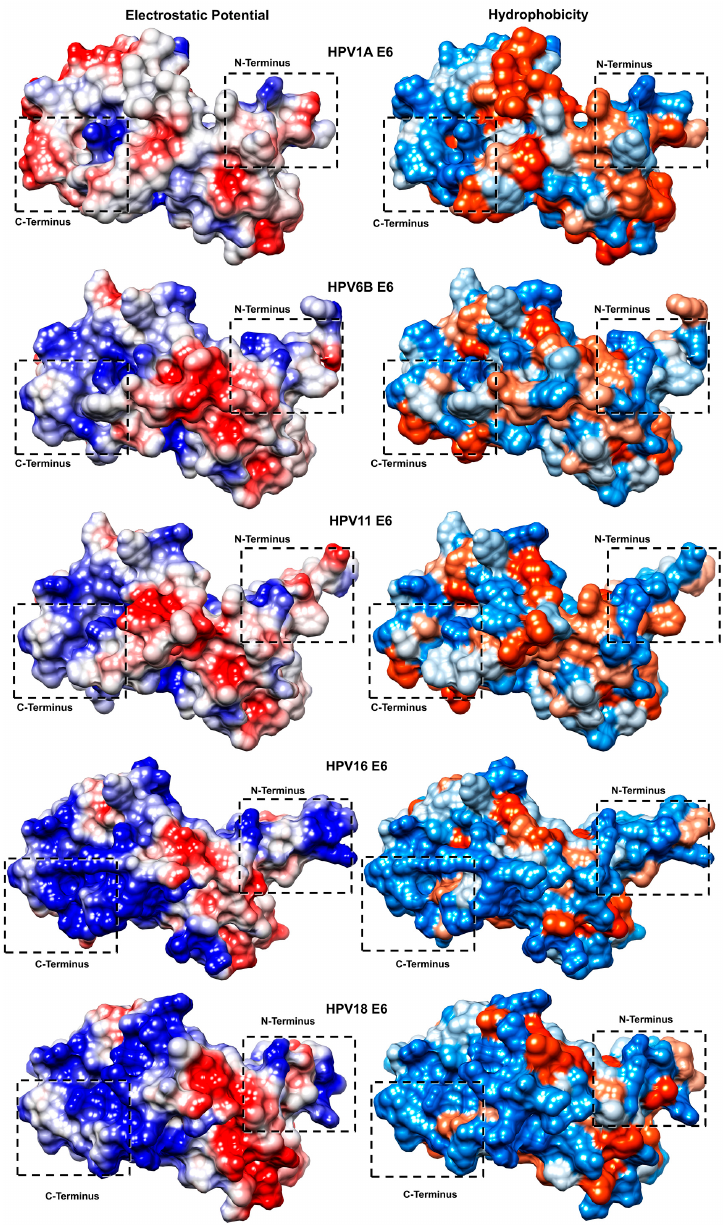
3 Figure 6. Distribution of electrostatic potential and surface hydrophobicity. The electrostatic potential distribution is shown in blue in the positively charged regions, red in the negatively charged regions, and white in the neutral regions. The hydrophobicity distribution on the protein surfaces is shown in blue for hydrophilic regions, orange for hydrophobic regions, and blank for neutral regions. The rectangles dotted in black show the regions corresponding to the N- and C-terminal surfaces. HPV1A, HPV6B, and HPV11 (control and low-risk) oncogenic E6 proteins have a greater proportion of neutral and hydrophobic electrostatic characteristics in the regions corresponding to the N- and C-terminal surfaces. The distribution of electrostatic potential and hydrophobicity of the surfaces of highly oncogenic HPV16 and HPV18 E6 proteins present predominantly positive and hydrophilic characteristics at the termini of both structures.